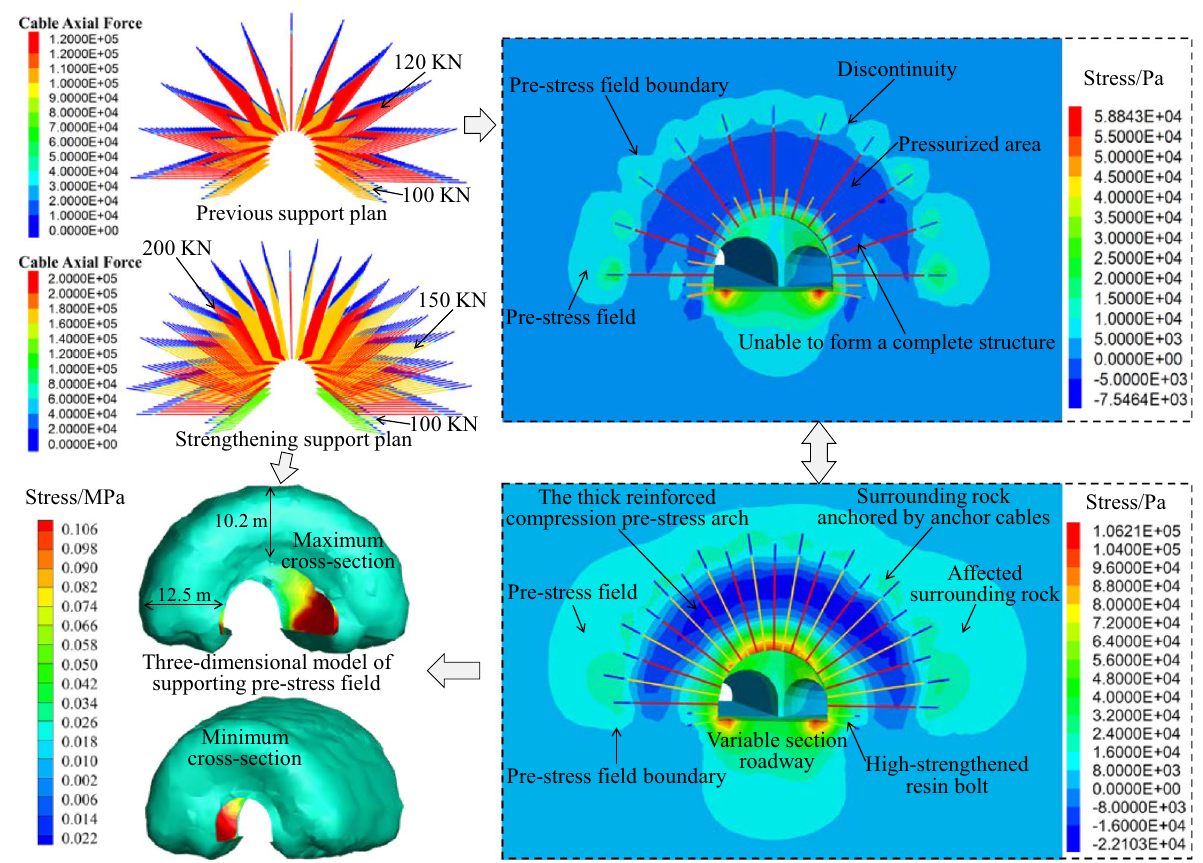
Fig. 24 Comparison of pre-stress field between original support and reinforced